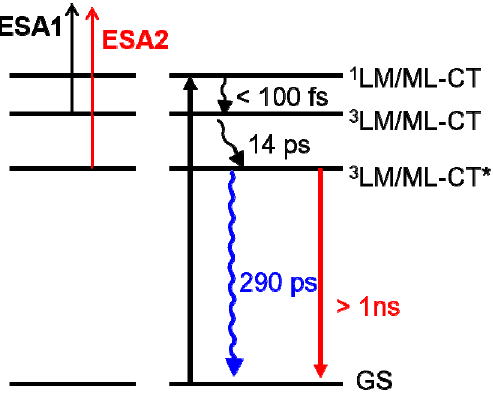
Figure 5. Diagram for the relaxation dynamics in the Au 10 complex. The 290 ps process shows solvent dependency (dichloromethane in this study versus 350 ps in toluene in a previous study [48]).